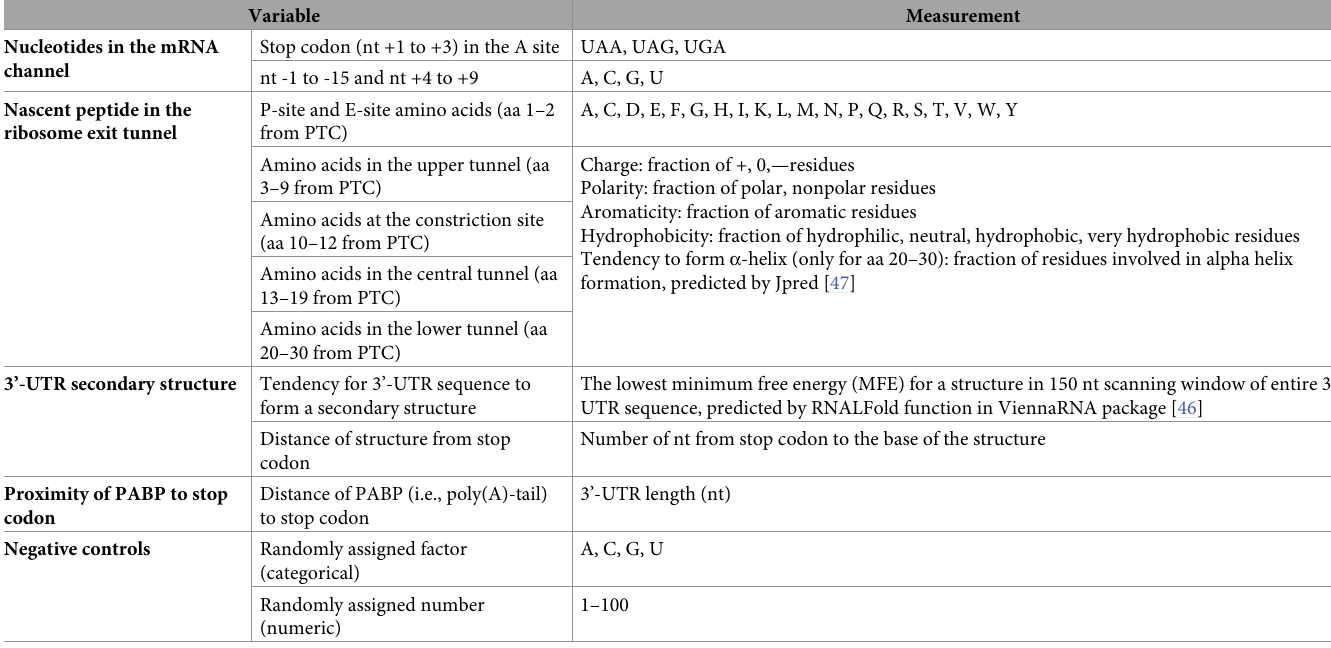
Table 1. Assessed X variables and their modes of